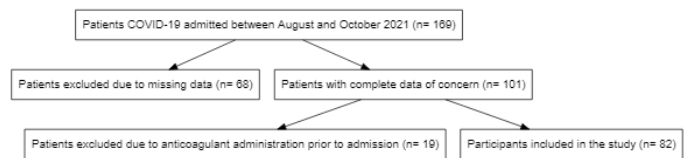
Figure 1. Flowchart of participant selection for the analysis.